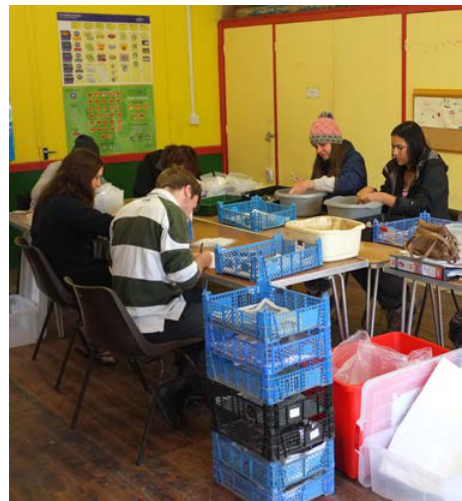
Fig. 10: Processing finds at the West Dean excavation